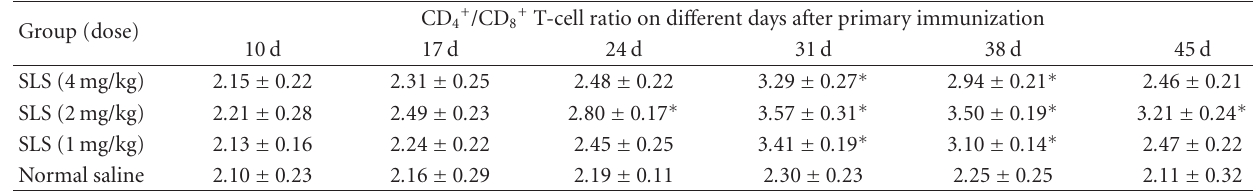
Table 3: The CD 4+ /CD 8+ T-cell ratio in PBMCs of SLS-treated and vaccinated chickens.